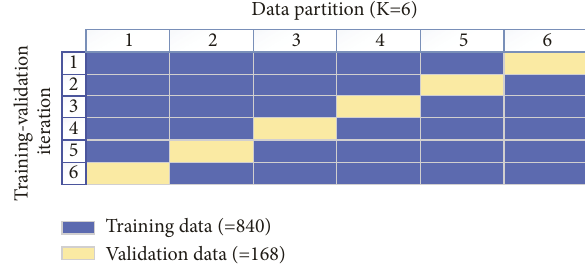
Figure 9: Six-fold